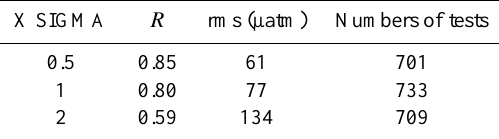
Table 5. Coefficient of correlation ( R ) between the measured p CO 2 and the p CO 2 data estimated with SOMLO and the rms in function of the sigma apply for the noise 0.5, 1 and 2 times the